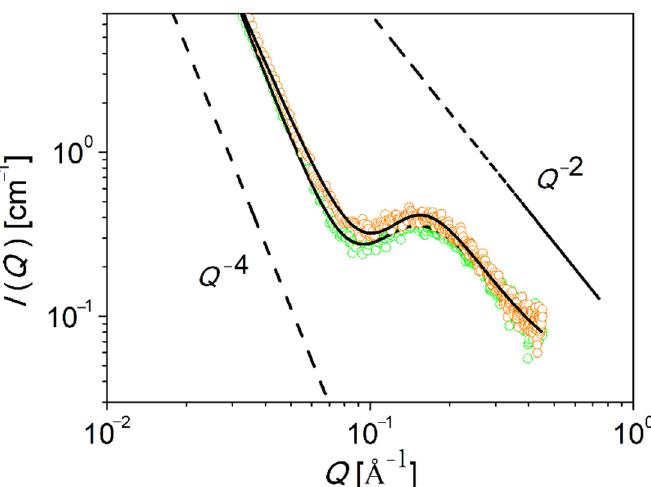
Figure 2. SAXS data from PEG-thy/dat at T = 333 K (green symbols) and T = 353 K (orange symbols). The black lines correspond to the fit to SAXS data with the modified RPA model. The dashed black lines demonstrate distinct Q dependencies if the SAXS data would follow different power law, I ( Q ) ∝ Q − P , with P = 2 or